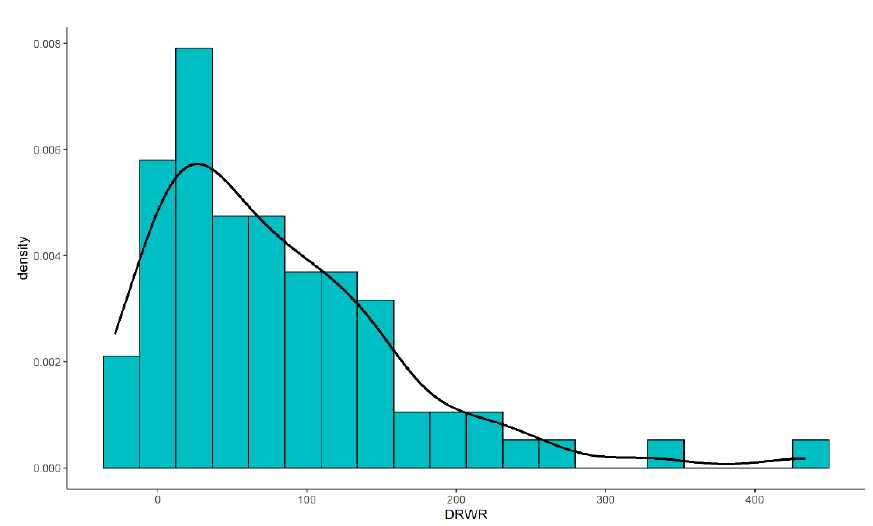
Figure 2. The histograms and density plot of the DRWRs (%). The DRWRs among the recipients concentrated in the range of 0 to 100%.